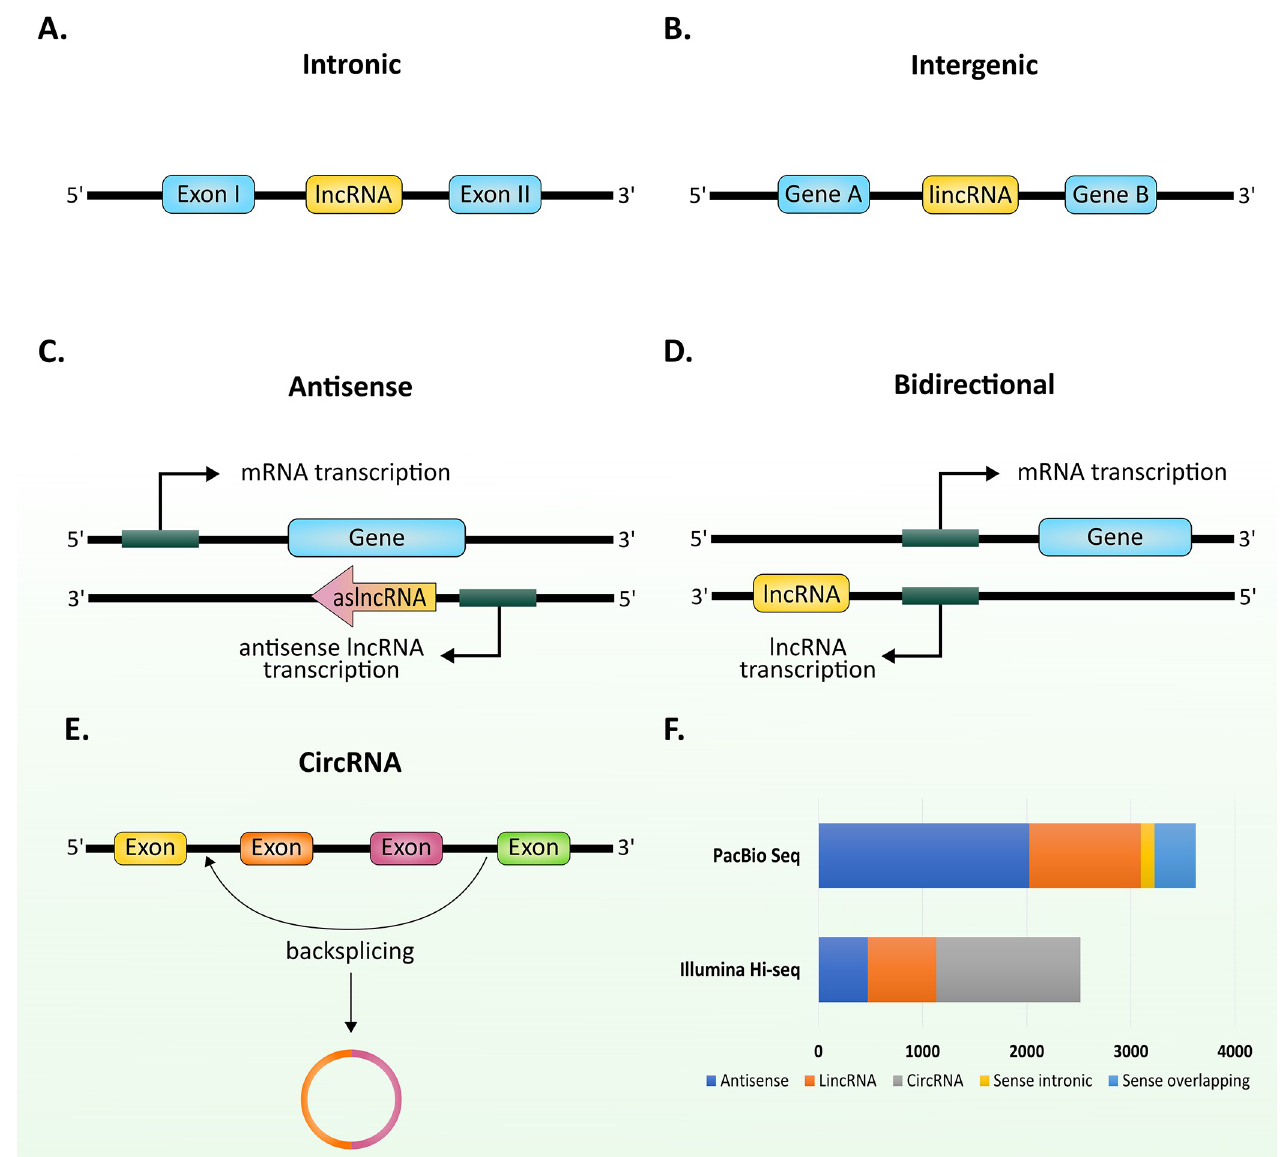
Fig 1. Graphical representation of different types of lncRNAs identified in P . falciparum . AU : AbbreviationlisthavebeencompiledforthoseusedinFigs 1 (cid:0) 4 andTable 1 : Pleaseverifythatallentriesarecorrect : (A) Intronic lncRNAs, transcribed from the intronic region of protein-coding genes. (B) lincRNA, located between 2 protein-coding genes. (C) Antisense lncRNAs, transcribed from the antisense strand of protein-coding genes. (D) Bidirectional lncRNA, transcribed from the opposite strand by a bidirectional promoter, and (E) circRNAs generated through back-splicing of transcripts with intronic, exonic or intronic and exonic fragments. (F) Putative lncRNA identified in P . falciparum using PacBio and Illumina sequencing [27,35].Both studies reported a relatively large number of differentially expressed lncRNAs during intra erythrocytic development. circRNA, circular RNA; lncRNA, long ncRNA; lincRNA, long intergenic lncRNA.